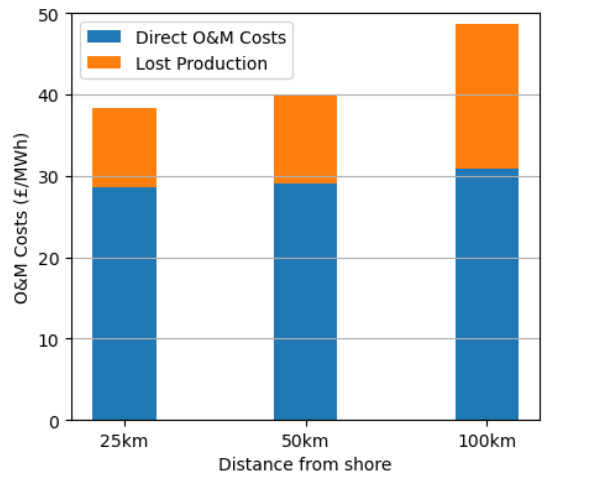
Figure 5. Baselinedirect O&M costs and lost production, Scenarios 2–4.